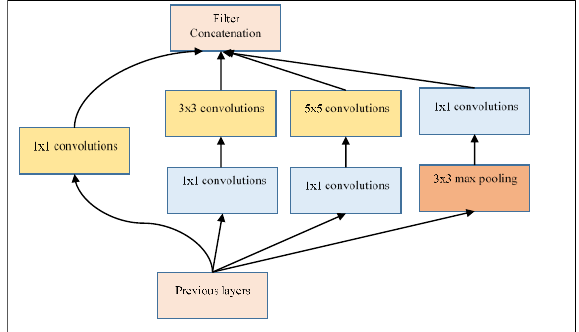
Figure 2. Inception module with dimension reductions